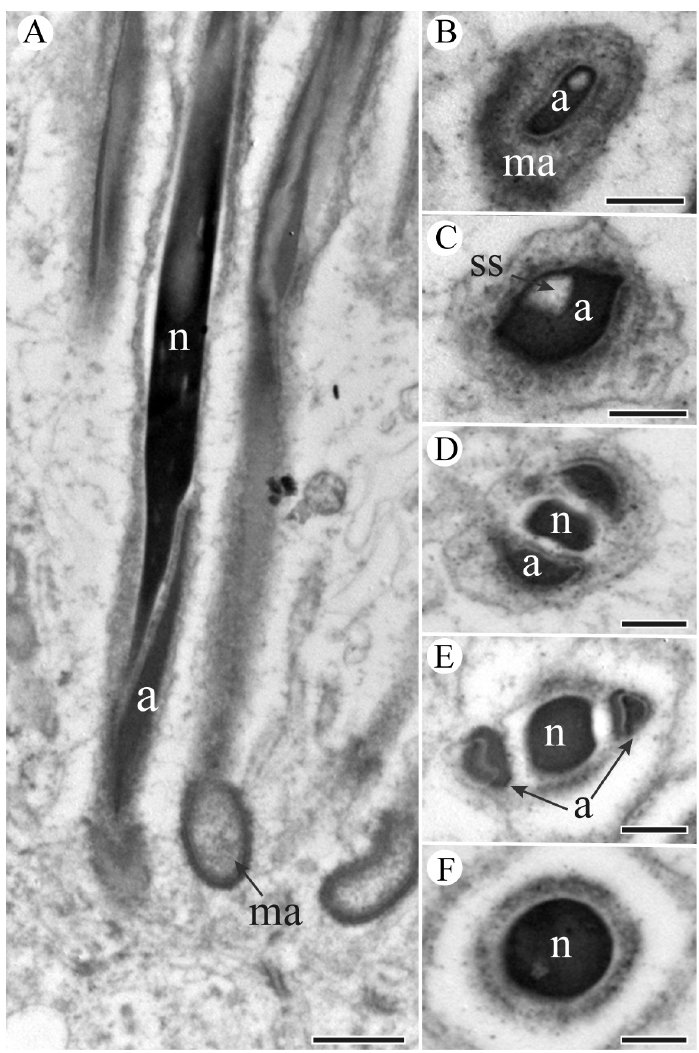
Figure 2. TEM micrographs of S. yangi sperm head region. A Longitudinal section of sperm head, showing the head region (including acrosome (a) and nucleus (n)) inserted into a homogenous matrix (ma) B Cross-section through the tip of acrosome (a), showing acrosome is surrounded by a homogenous matrix (ma) C Cross-section through the mid-acrosome (a), showing acrosome (a) and subacrosomal space (ss) D and E Cross-sections of base of acrosome (a), showing nucleus (n) and two acrosomal pro- cesses F Cross-section through circular nucleus (n). Scale bars: 500 nm ( A ), 200 nm ( B–F ). Karenia caelatata Distant,